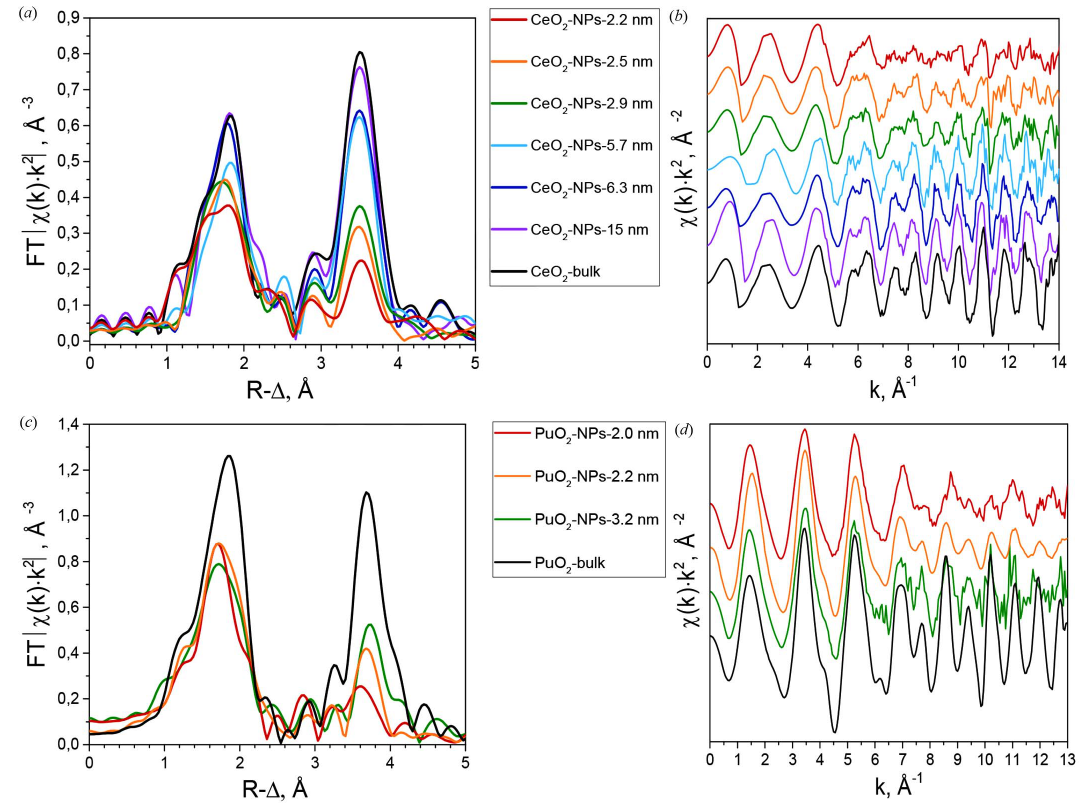
Figure 1 ( a , b ) Ce K -EXAFS: ( a ) FT magnitude of EXAFS data ( k = 3–13), ( b ) k 2 -weighted (cid:4) ( k ) experimental functions; ( c , d ) Pu L 3 -EXAFS: ( c ) FT magnitude of EXAFS data ( k = 3–13), ( d ) k 2 -weighted (cid:4) ( k ) experimental